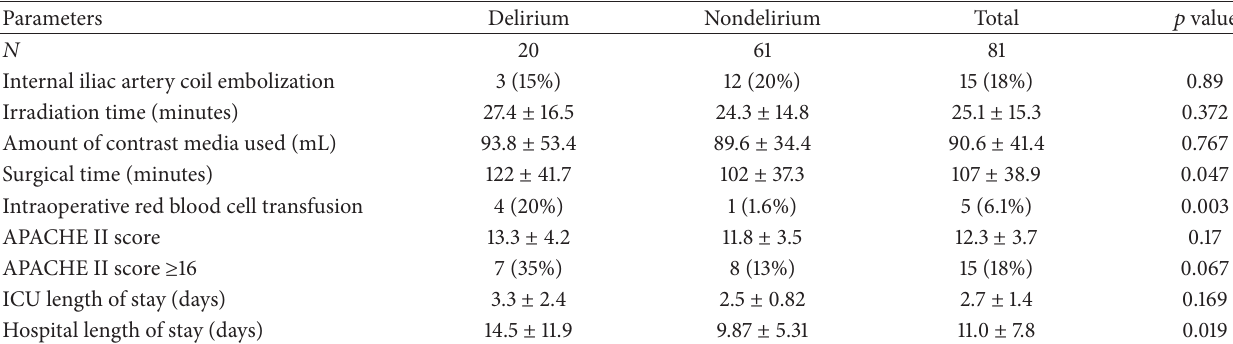
Table 2: Clinical parameters and outcomes of patients.